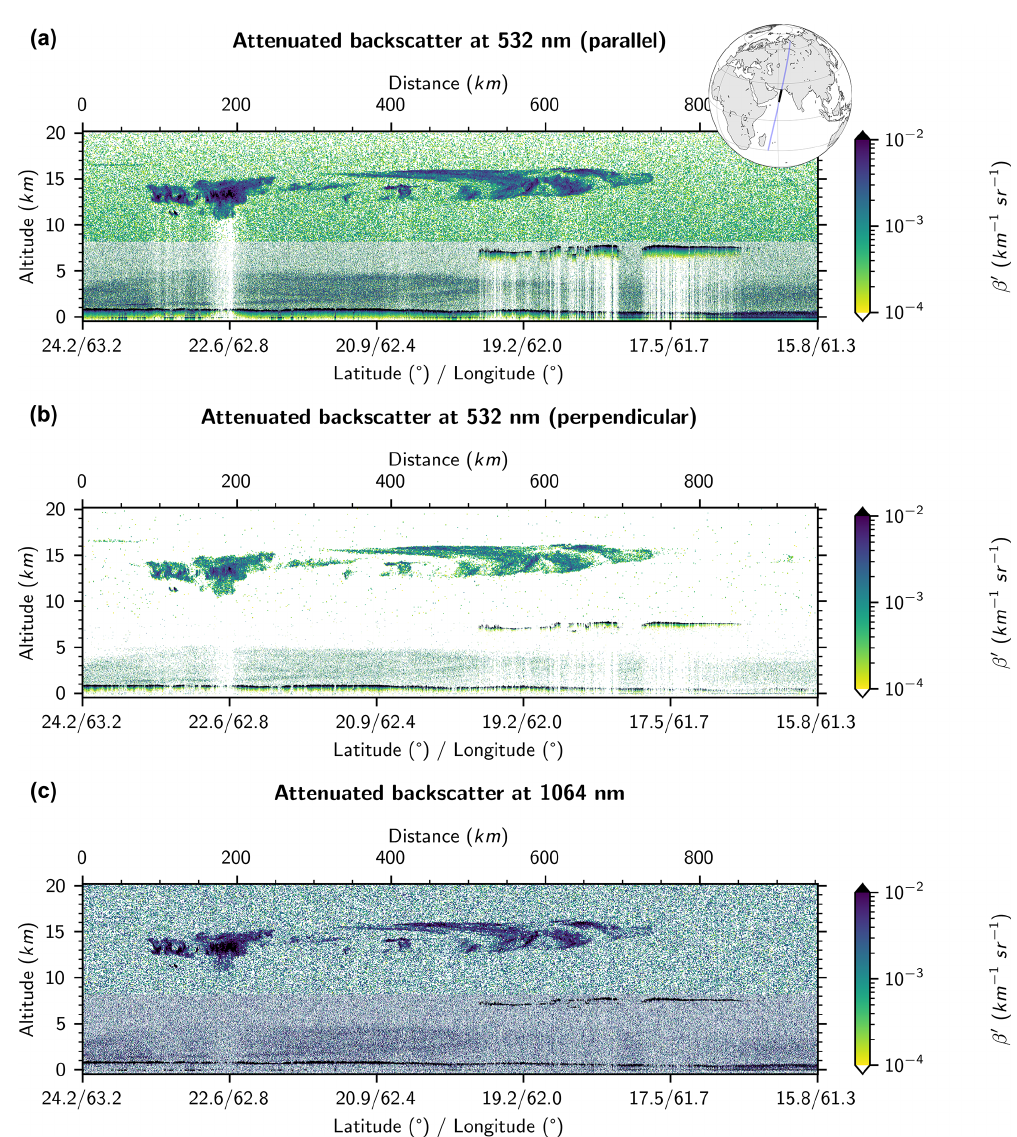
Figure 8. Curtain of attenuated scattering ratios measured by CALIOP during nighttime observations on 31 August, 21:46:37UTC (start point), daytime observations at (a) 532nm parallel (same as Fig. 1), (b) 532nm perpendicular and (c)